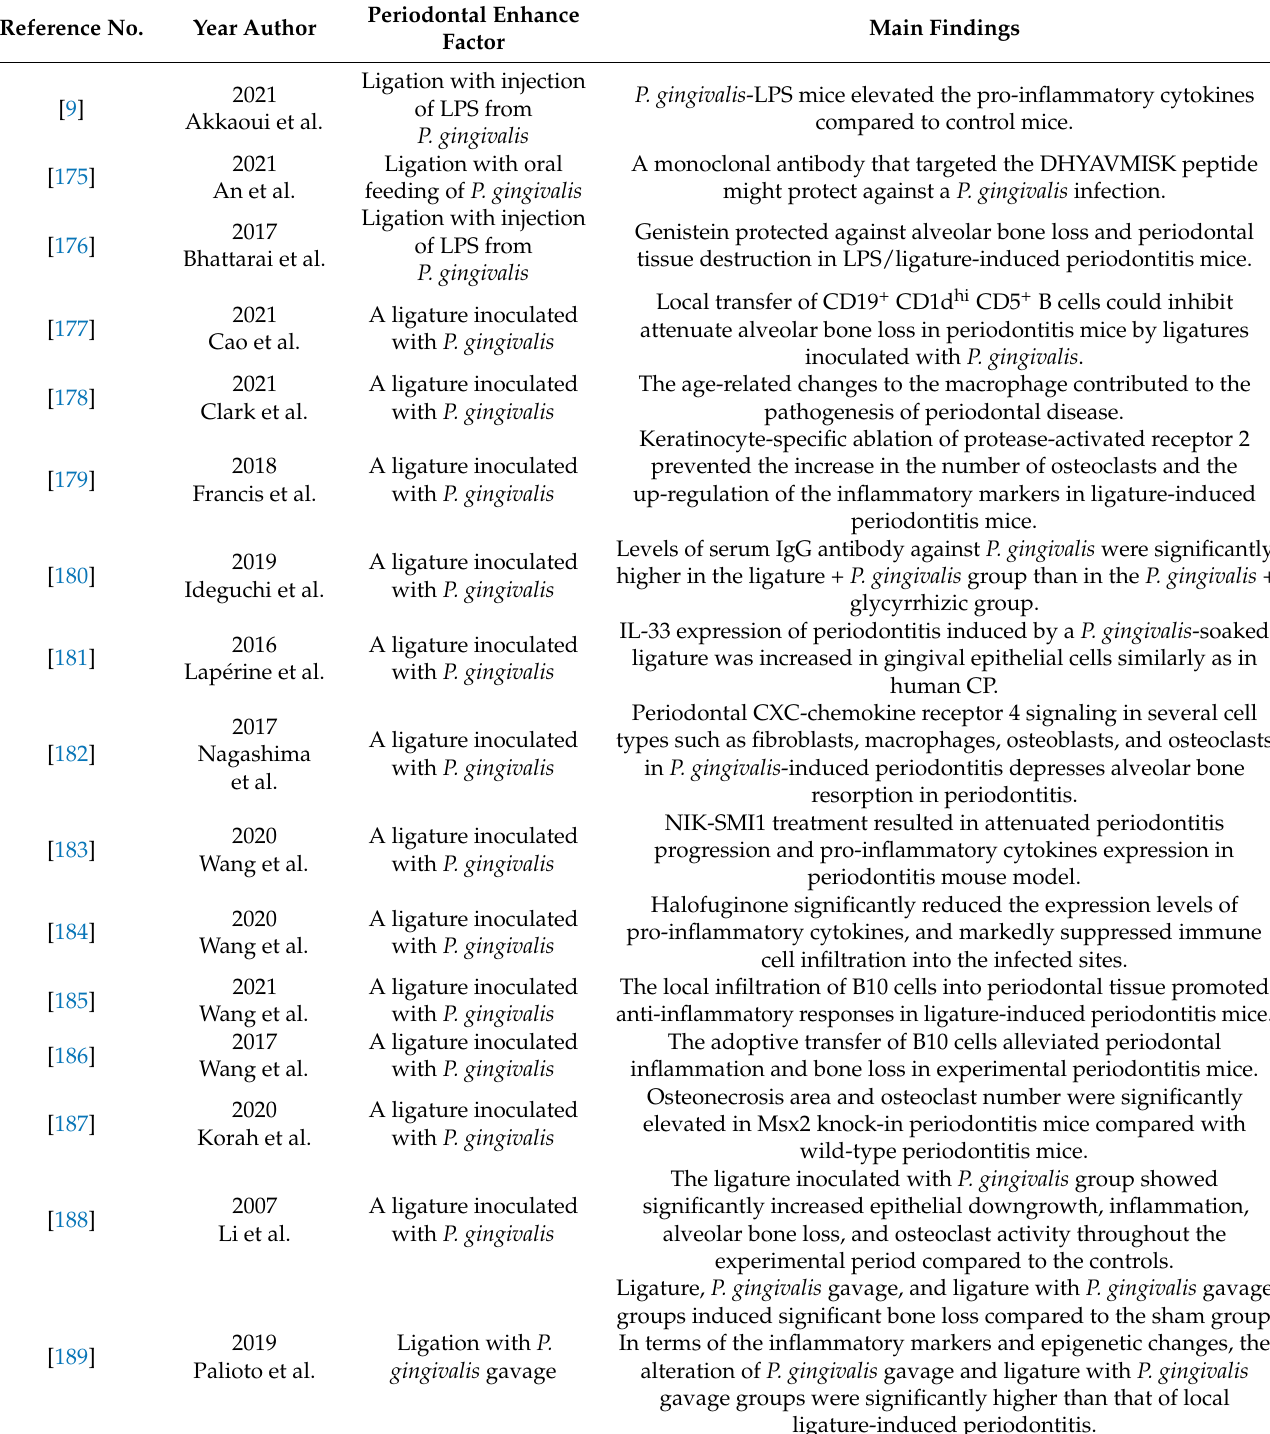
Table 8. Summary of ligature-induced periodontitis models with bacterial factors. Reference